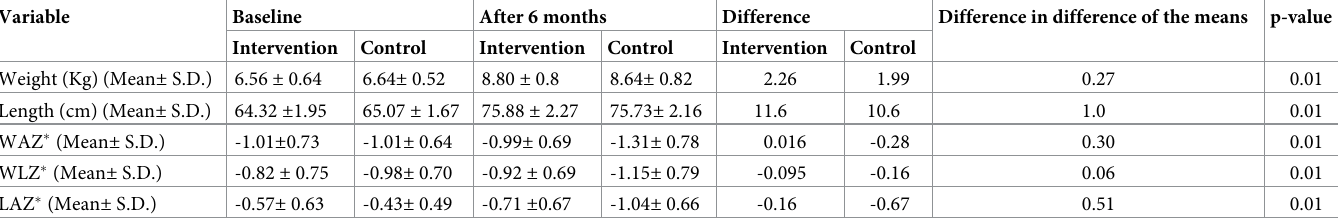
Table 2. Comparison of mean weight and mean length of infants in the intervention and control group at baseline and end-line. Variable Baseline